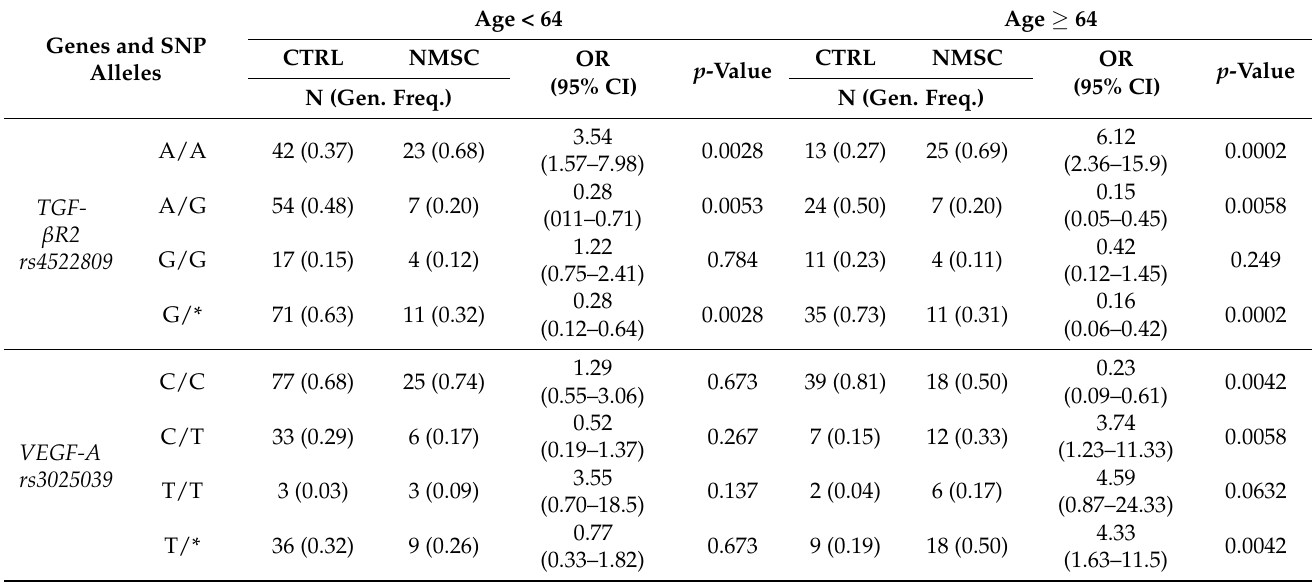
Table 4. Significantly different TGF- β R2 and VEGF-A SNP frequencies in non melanocitic skin cancer